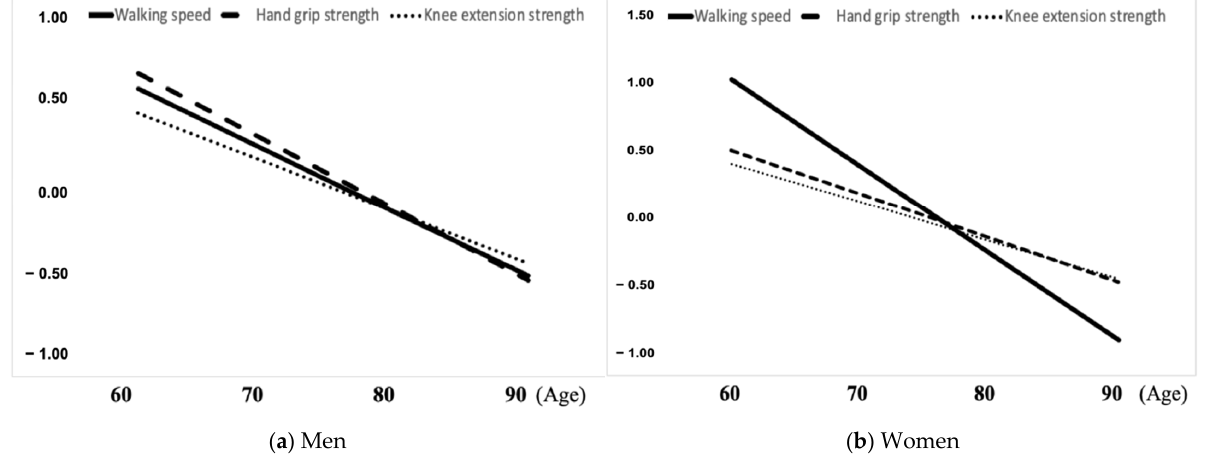
Figure 1. Changes in walking speed, hand grip strength, and knee extension strength with age in men and women. ( a ) Men; ( b ) Women. men and women. ( a ) Men; ( b )